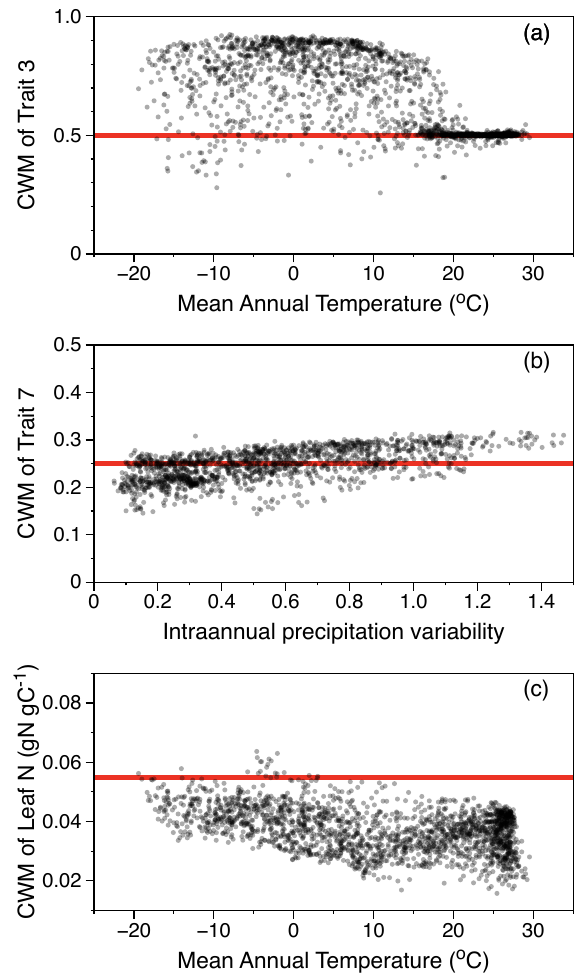
Fig. 13. (a) Scatter plot of the community-weighted means (CWMs) of trait parameter t 3 with respect to mean annual temperature. Trait parameter t 3 determines the critical temperature for the onset of plant growth in a linear function between − 5 ◦ C and 10 ◦ C. (b) Scatter plot of the CWMs of trait parameter t 7 with respect to intra- annual precipitation variability. Trait parameter t 7 determines the fractional allocation of carbon to belowground growth. Intra-annual precipitation variability is calculated as the coefficient of variation of the climatic monthly means of the precipitation forcing dataset. (c) Scatter plot of the CWMs of leaf N concentration with respect to mean annual temperature. Leaf N concentrations are calculated di- rectly as a linear function of trait parameter t 15 . Each grey point rep- resents the CWM across 2000 randomly sampled strategies within a grid cell. The red lines represent the means of the uniform prior distribution used in the random sampling of that particular trait pa- rameter. (a = 0 . 50 , b = 0 . 25 , c = 0 .